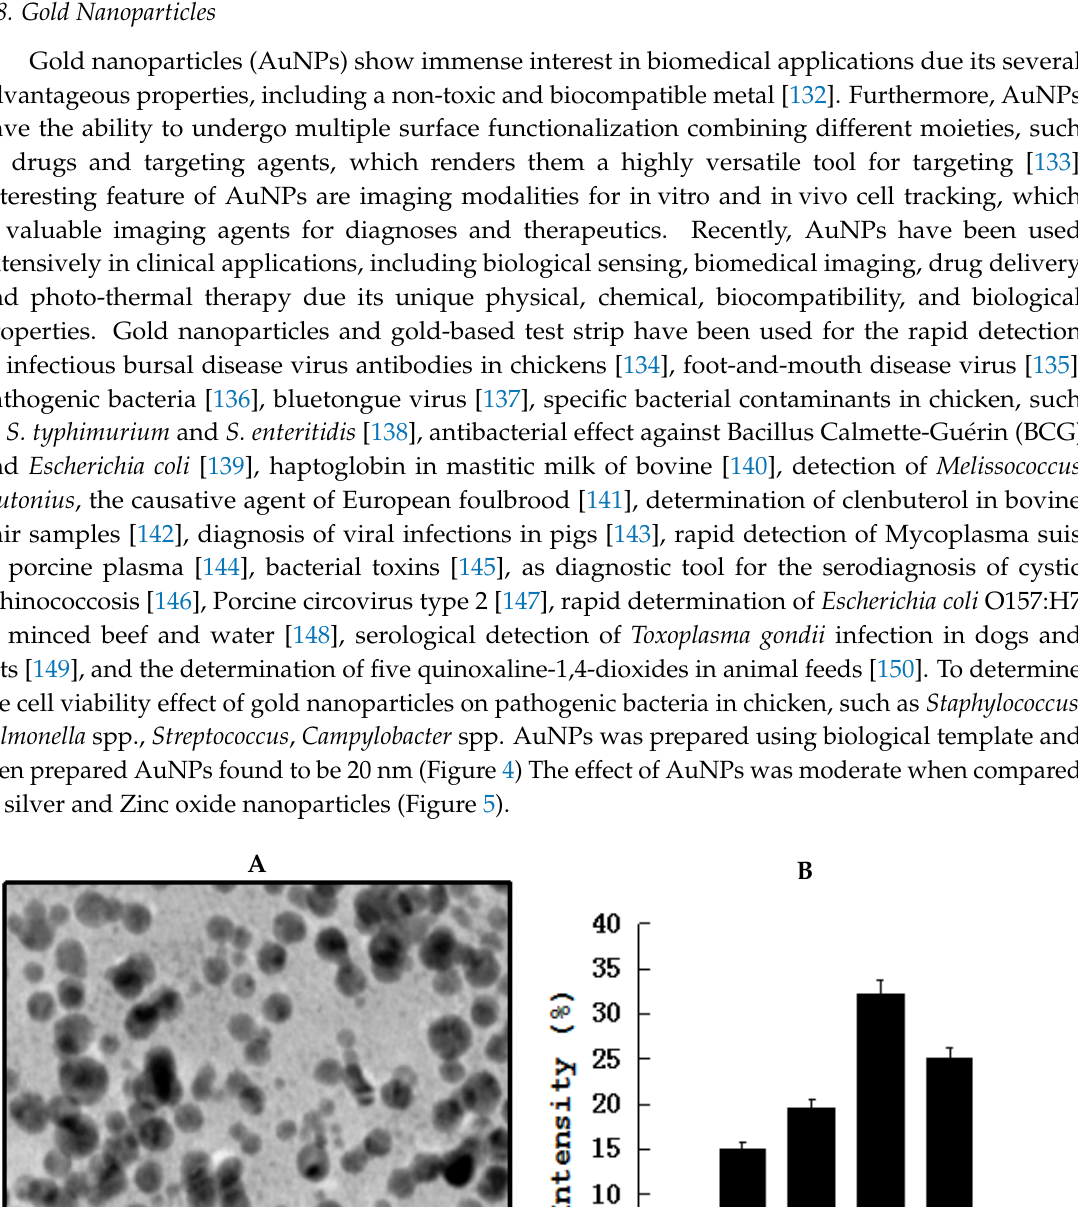
Figure 5. Effect of AuNPs on Staphylococcus spp., Salmonella spp., Streptococcus spp., and Campylobacter spp. in chicken. Staphylococcus spp., Salmonella spp., Streptococcus spp., and Campylobacter spp. cells were incubated with various concentrations of AuNPs. ( A ) Cell viability of Staphylococcus spp. and Salmonella spp. treated with AuNPs. ( B ) Cell viability of Streptococcus spp. and Campylobacter spp. treated with AuNPs. Bacterial survival was determined at 24 h by a CFU count assay. The experiment was performed with various controls, including a positive control (AuNPs and NB, without inoculum) and a negative control (NB and inoculum, without AuNPs). The results are expressed as the means ± SD of three separate experiments, each of which contained three replicates. Treated groups showed statistically significant differences from the control group by Student’s t test ( p < 0.05). 2.9. Iron Oxide Nanoparticles Murine model that was exposed to iron oxide nanoparticles exhibited significant attenuated inflammatory reactions that are associated with DTH, including the footpad swelling, the infiltration of T cells and macrophages, and the expression of interferon- γ , interleukin-6, and tumor necrosis factor- α in the inflammatory site in a dose-dependent fashion, significantly, and also iron oxide nanoparticles also demonstrated a suppressive effect on ovalbumin-stimulated production of